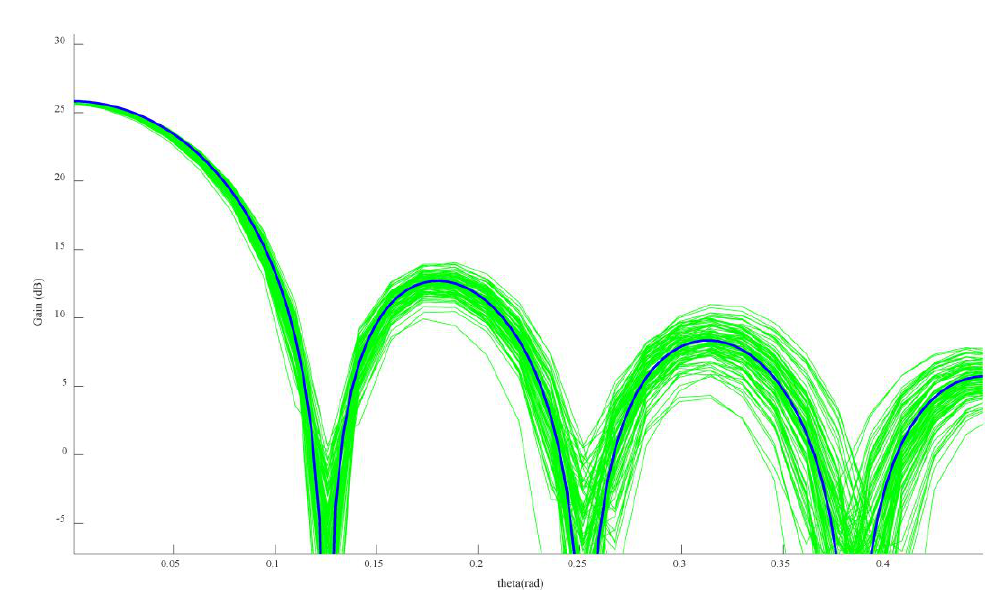
Figure 13. The simulation results of the realistic gain of the antenna with the optimized tolerances. Only 100 sets of results are drawn in the figure for clarity. Only the array factor was considered and the effect of the horn antenna was ignored.